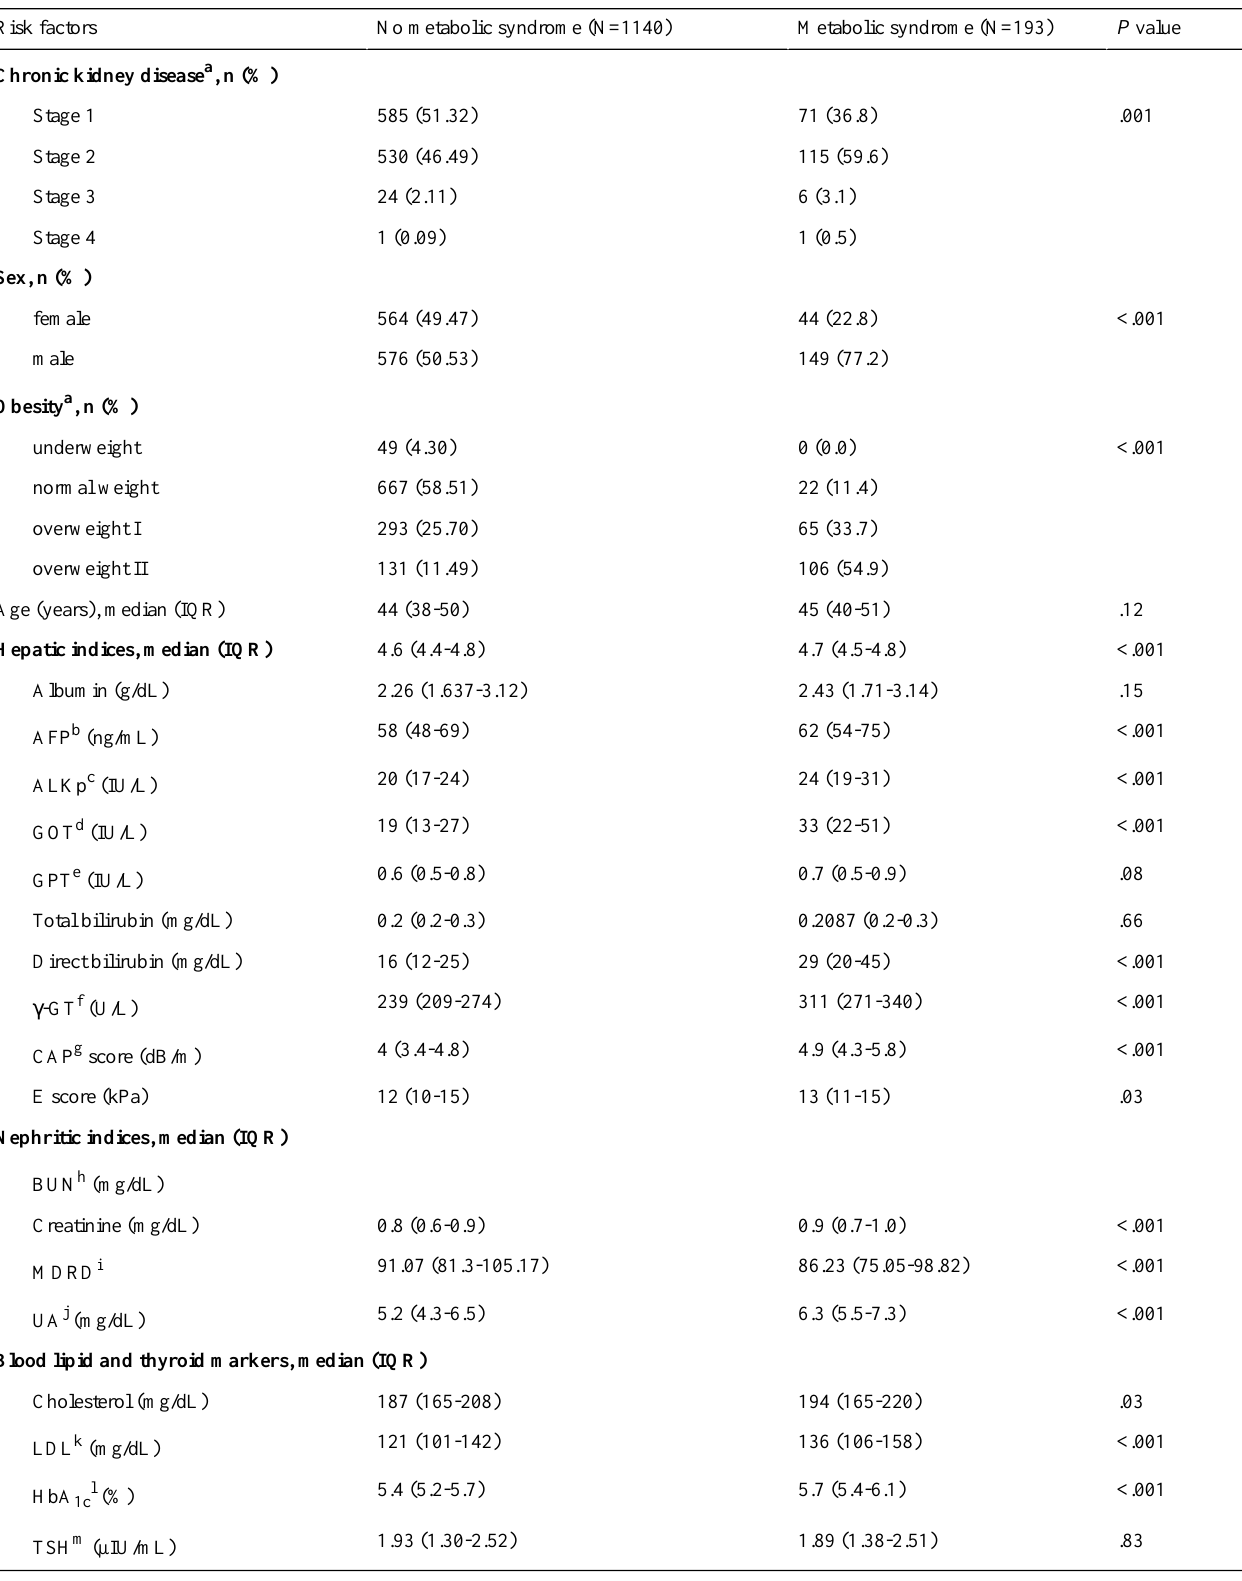
Table 1. Descriptive statistics and testing of risk factors in health examination data with potential metabolic syndrome as the dependent